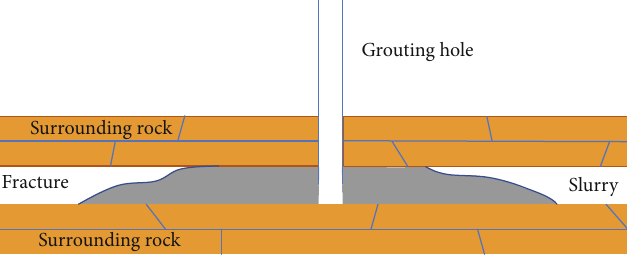
Figure 4: Schematic diagram of grout fl owing in fracture. Table 1: Numerical simulation